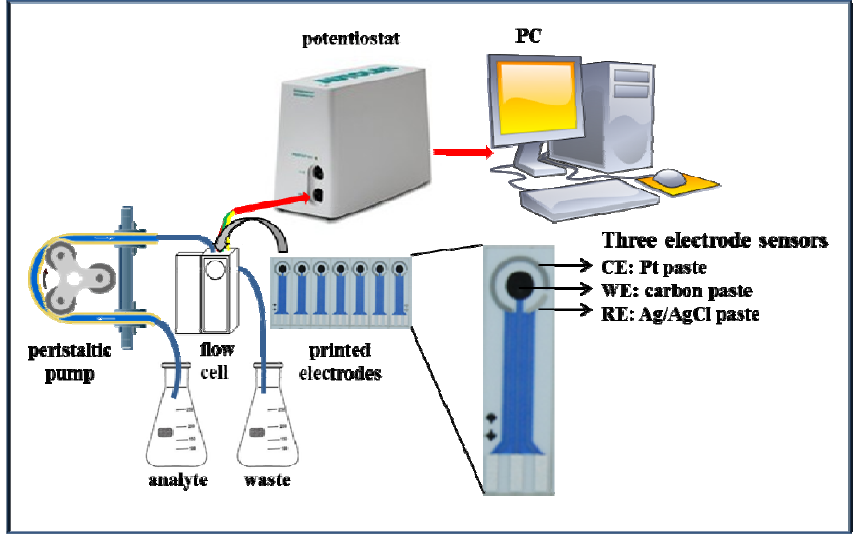
Figure 2. Schematic diagram of the microfluidic system with electrochemical